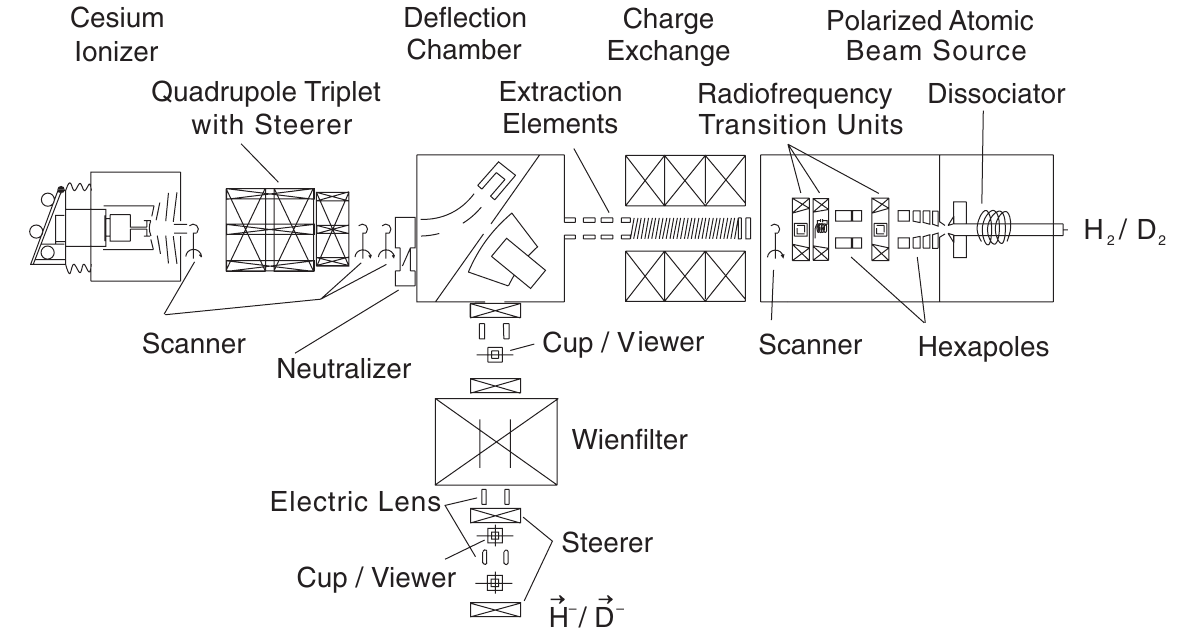
FIG. 1. Setup of the polarized ion source at